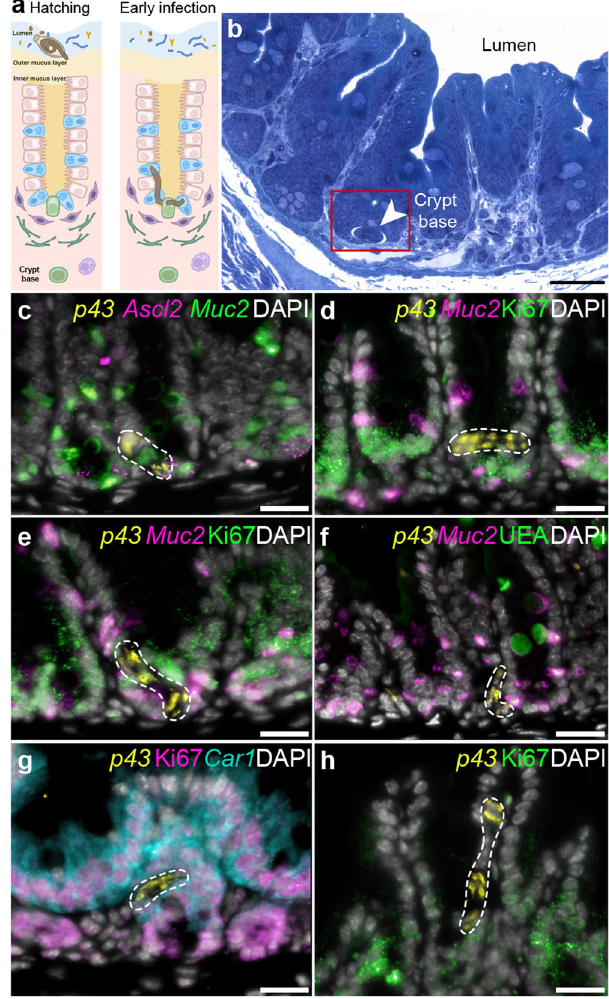
Fig. 1 Whipworm L1 larvae are predominantly associated with mitotically active cells at the bottom of the crypts of Lieberkühn in the caecum. a Illustration of the processes of egg hatching at the caecal lumen and larvae infection of the IE at the base of the crypts. b Representative image of toluidine blue-stained transverse sections from caecum of mice infected with T. muris (72 h p.i.), showing whipworm larvae (arrowhead) infecting cells at the base of crypts. Scale bar 30 μ m. Image is representative of 15 larvae found during the fi rst 72 h of infection across two independent experiments with three mice per timepoint (3, 24 and 72 h p.i.) each. c – h p43 + T. muris larvae (dashed white outline, yellow staining) were detected in close association with: c Ascl2 + and Ascl2 + (magenta) /Muc2 + (green) cells (putative stem cells and DSCs, respectively), d – e Ki-67 + (green)/ Muc2 + (magenta) DSCs, f Muc2 + (magenta) DSCs and g Ki- 67 + (magenta)/ Car1 + (aqua) enterocyte progenitor cells within the dividing zone of the mouse caecal epithelium. h In one instance, we observed a larva within the differentiated zone of the caecal crypt. Ki-67 + cells stain in green. In c to h , nuclei are stained with DAPI (white). Images are representative of 20 larvae found in an experiment with three mice at 72 h p.i. All scale bars = 15 μ